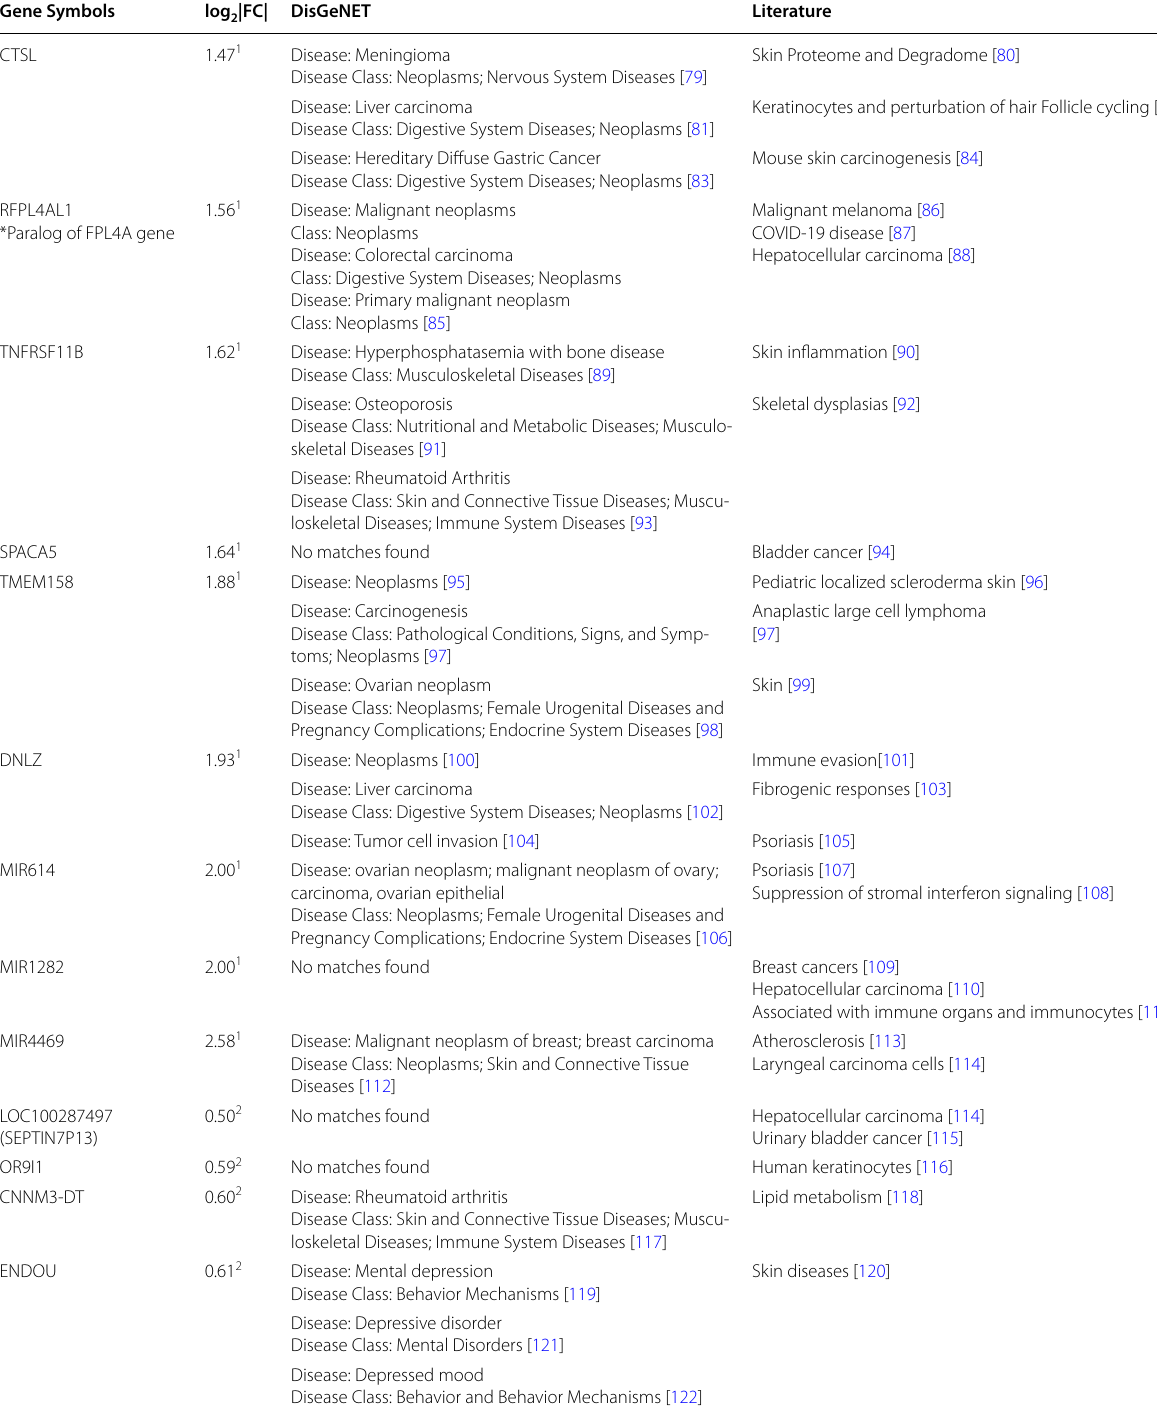
Table 2 Validation of significant DEGs using DisGeNET and literature evidence for their related diseases. log from ExAtlas meta-analysis web